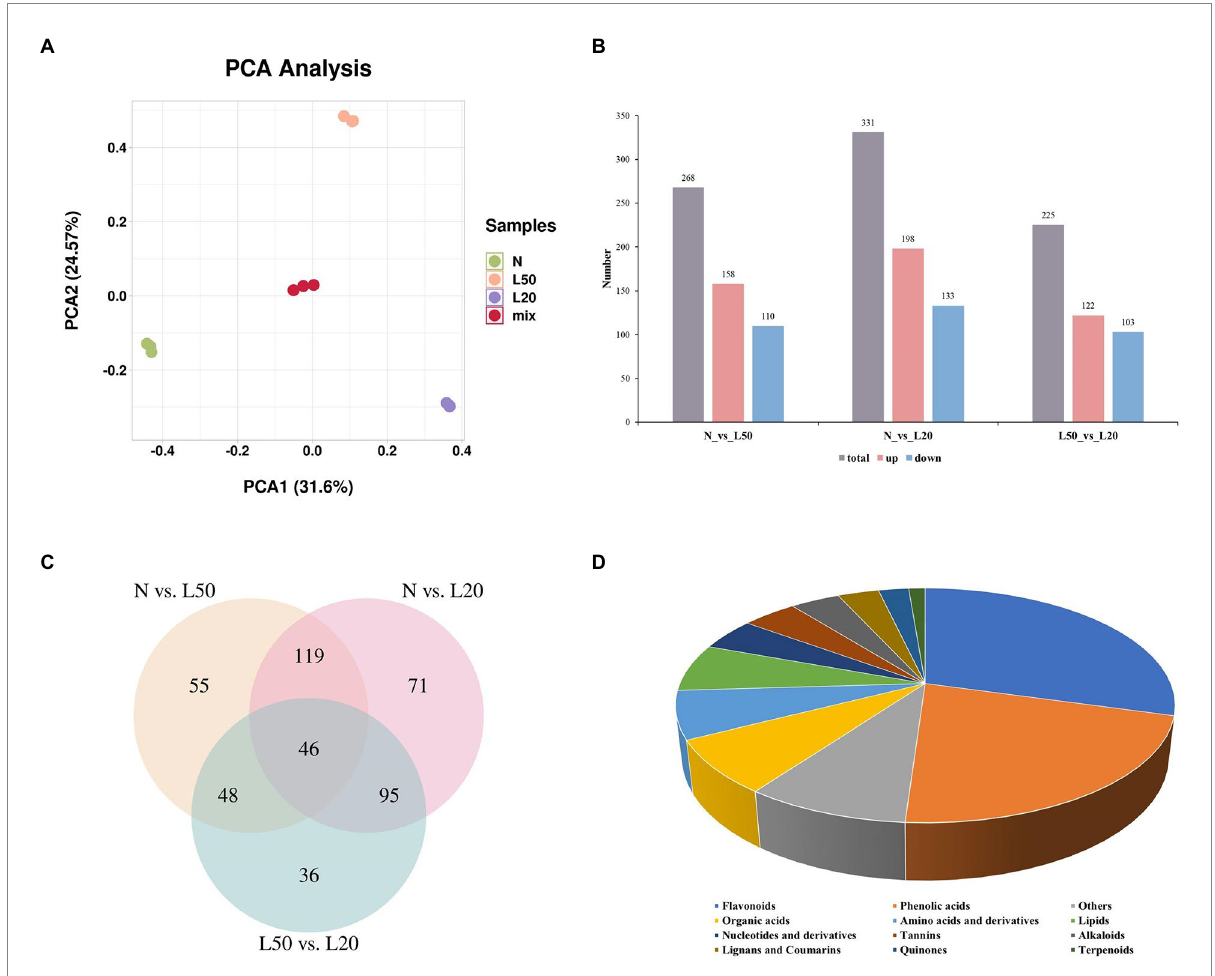
FIGURE 7 Identification of differential metabolites of J. mandshurica under shade. (A) PCA of different samples. (B) The statistical analysis of upregulated and downregulated differentially expressed metabolites in different comparison groups. (C) Venn diagram showing the number of metabolites in N, L50 and L20. (D) Component analysis of the identified differentially abundant metabolites from leaves. N: natural sunlight. L50: 50% sunlight to go through. L20: 20% sunlight to go